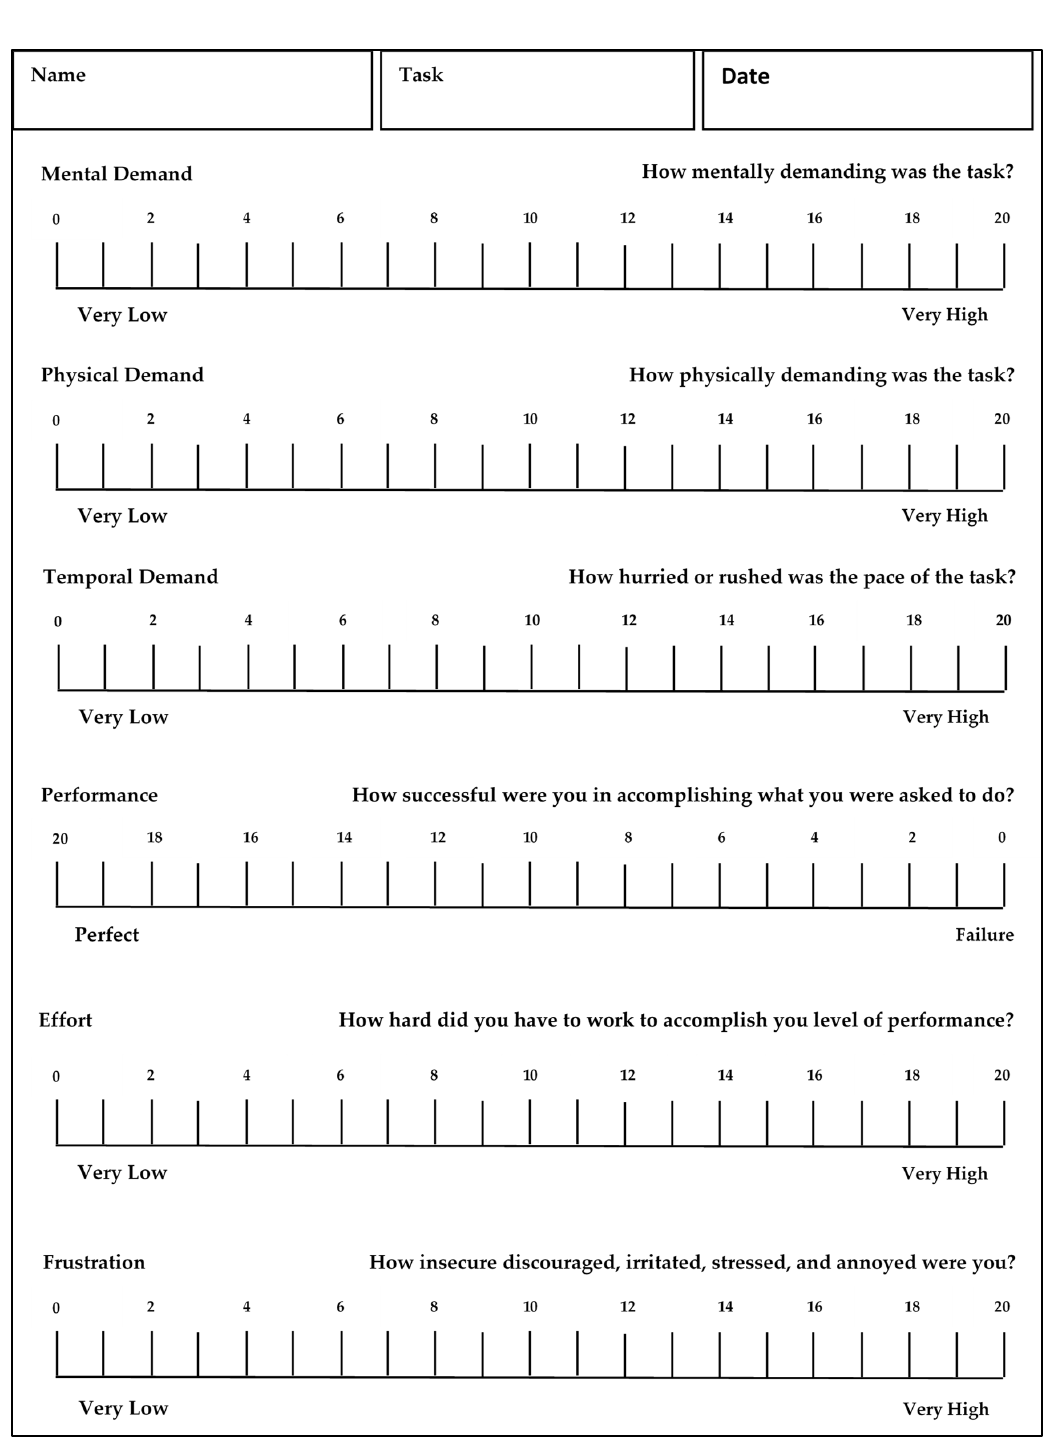
Figure A1. NASA-TLX Scale. This scale was part of the structured questionnaire used in the interviews with PHC workers.